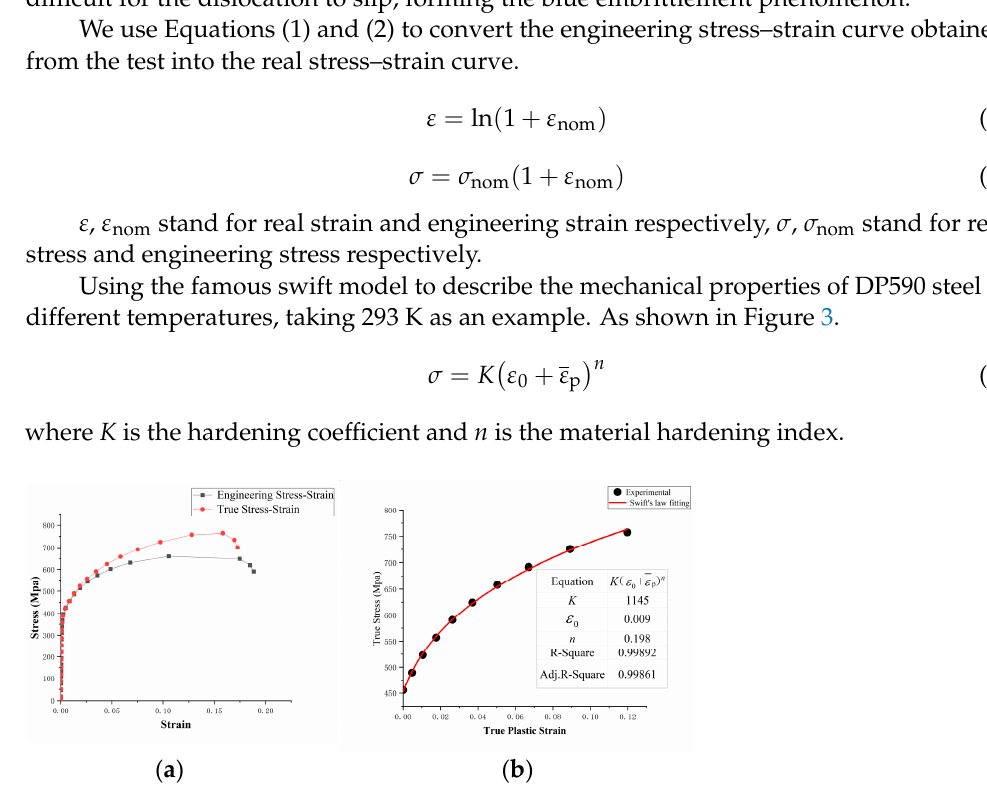
Figure 3. ( a ) Engineering and true stress–strain plots and ( b ) true plastic stress–strain approximate curve for realizing hardening parameters.